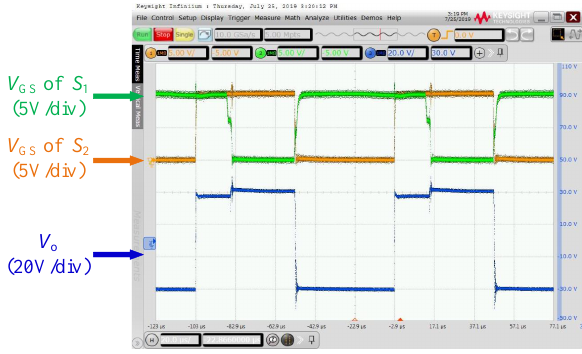
Figure 8. Experimental waveforms when the turns ratio is 5:1:3 and the duty ratio is D 1 = 0.5, D 2 = 0.66.